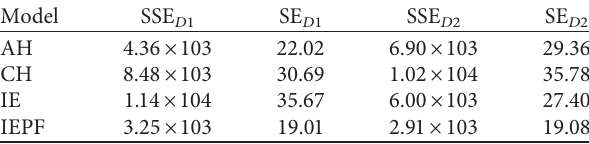
Table 18: Accuracy of each model for example 4. Model